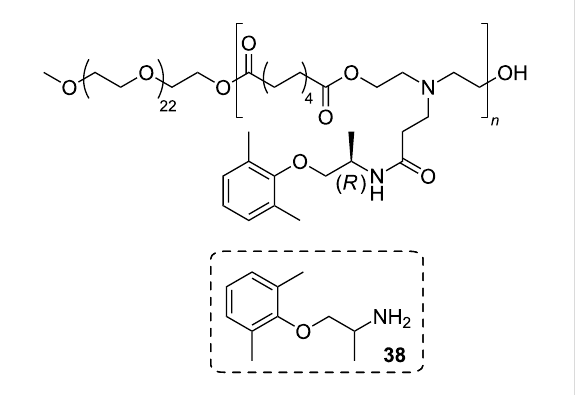
Figure 18: Polyesters comprising mexiletine ( 38 ) moieties.